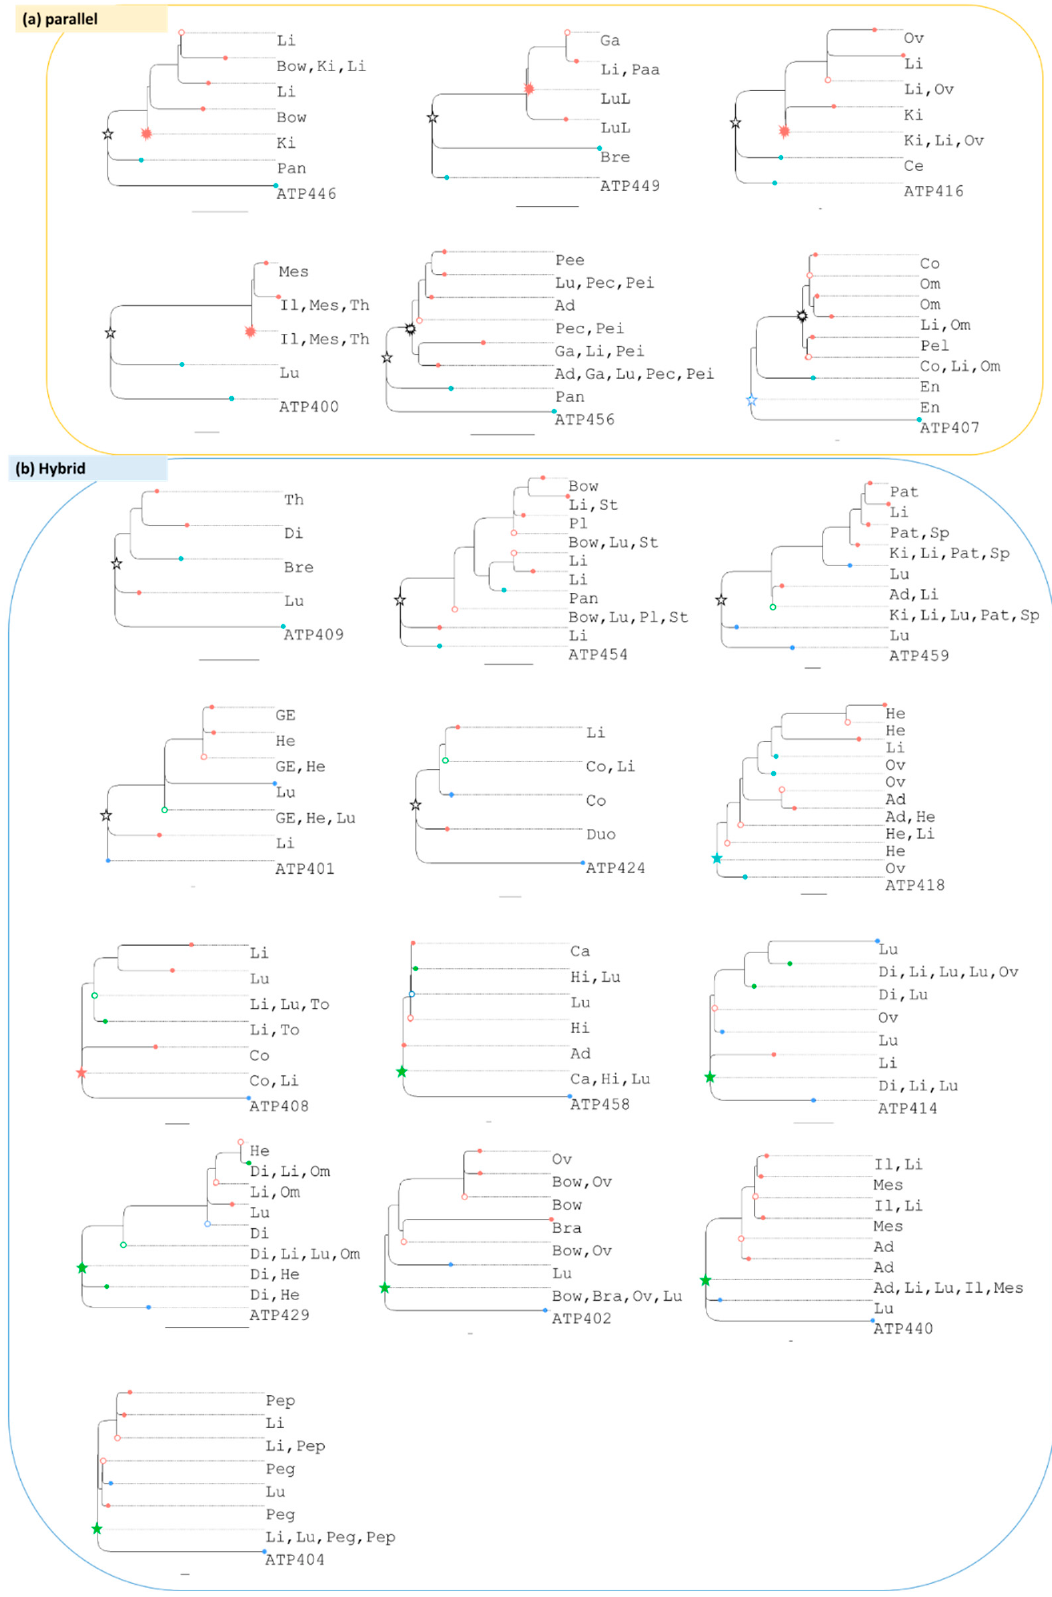
Figure 3. Phylogenies from the Zhao cohort. Inferred phylogenies were rooted with normal cell sequence (patient ID shown next to the normal cell) and classified into the parallel ( a ) and hybrid progression models ( b ), based on the shape of the phylogenies and the locations of clones (Blue and red tips: clones identified only within the primary and metastatic tumors, green tips: clones identi- fied in both primary and metastatic tumors; open circle: ancestral clone, star: most recent common ancestor [MRCA], starburst: MRCA of metastatic clones [meta-MRCA], black star and starburst: MRCA and meta-MRCA clones that are not found in any tumors). Tumors that contain a clone are listed next to each tip. Below is the abbreviation used for each tumor site: Adrenal (Ad), Bladder (Bl), Bone (Bon), Bowel (Bow), Brain (Bra), Breast (Bre), Carinal LN (Ca), Cervix (Ce), Colon (Co), Diaphragm (Di), Duodenum (Duo), Dura (Dur), Endometrium (En), Esophagus (Es), Gallbladder